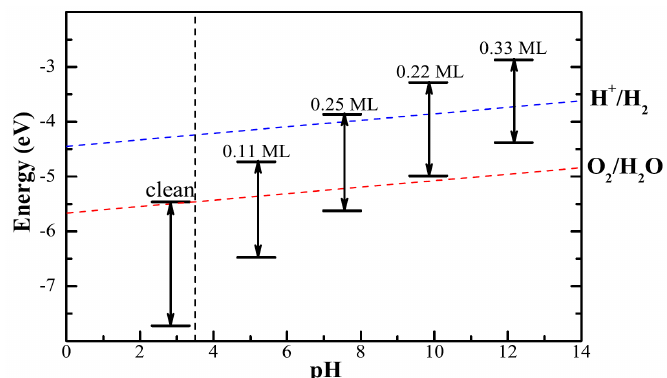
Figure 7. The band edges of clean and adsorbed Cu 2 O(100) surface with respect to the redox potential of water. The blue and red dashed lines represent the reduction potential and the oxidation potential of water as function of pH value, respectively. The black vertical dashed line is at a pH =